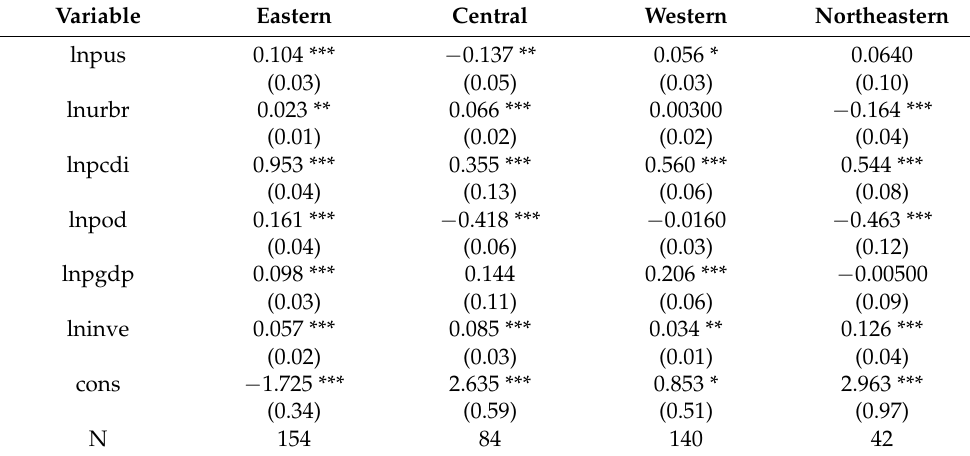
Table 7. Regression results of panel data in different regions. Variable Eastern Central Western Northeastern lnpus 0.104